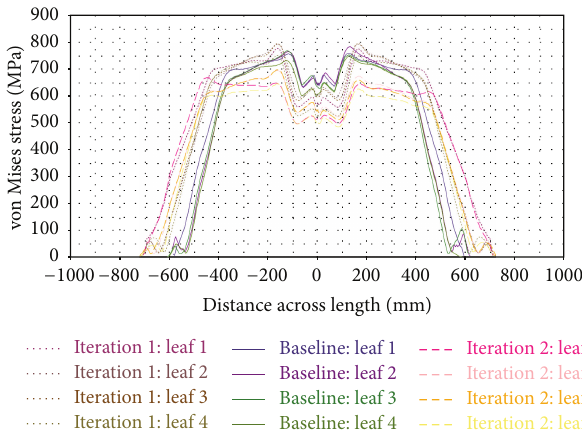
Figure 11: von Mises stress across length plot of vertical